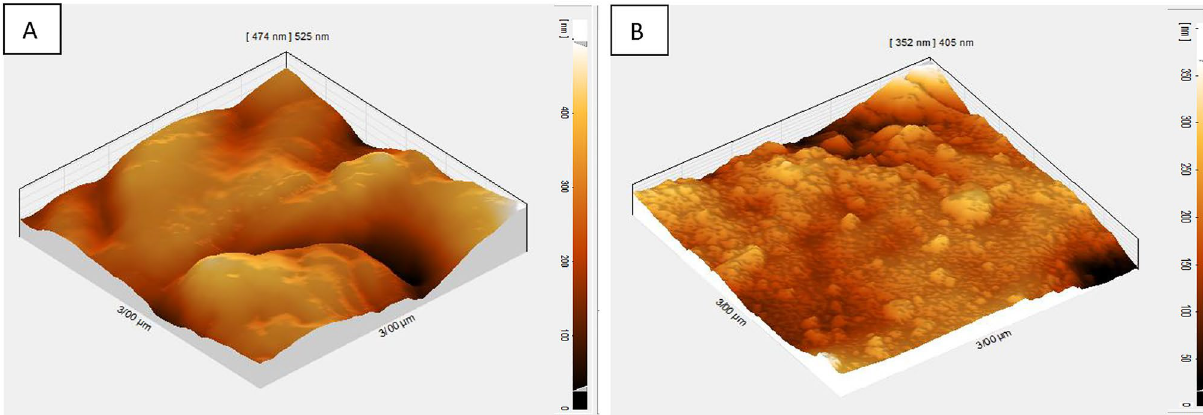
Figure 3. Atomic force microscope (AFM) images of seed surface at 10 µm. ( A ) control (without plasma treatment). ( B ) seed surface after receiving 180 s, 50 W plasma treatment. The images was taken from identical locations on the dorsal side of the wheat